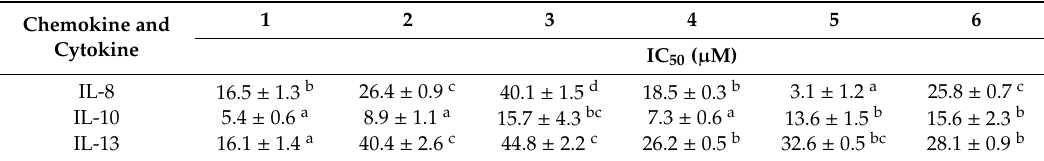
Values represent the means ± S.D. of three determinations. Values with different superscripts in the same columns are significantly different ( p < 0.05).